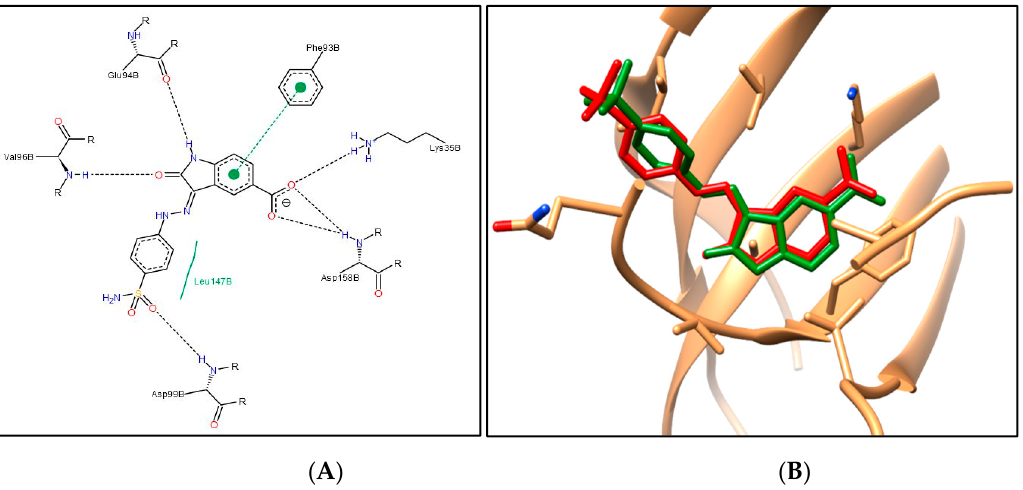
Figure 5. ( A ) The 2D diagram for the docking pose of the oxindole ligand in CDK4 binding site; ( B ) 3D illustration of the superimposition for the docking pose (green) and the added (red) oxindole ligand in the CDK4 binding site (RMSD = 0.879Å).